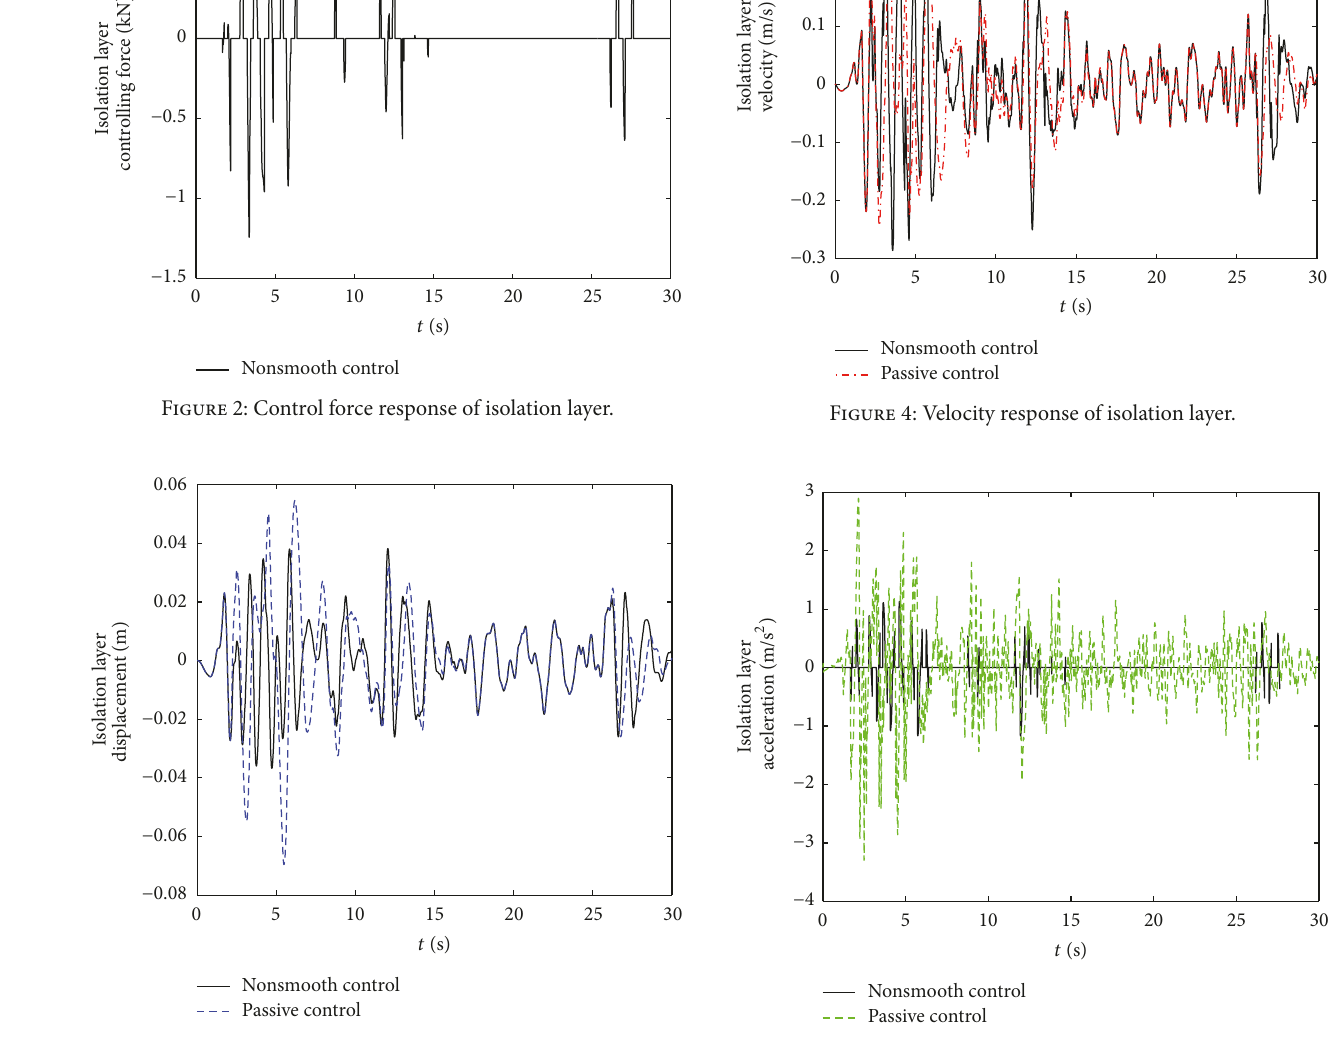
Figure 3: Displacement response of isolation layer. Table 1: Comparison of peak data.